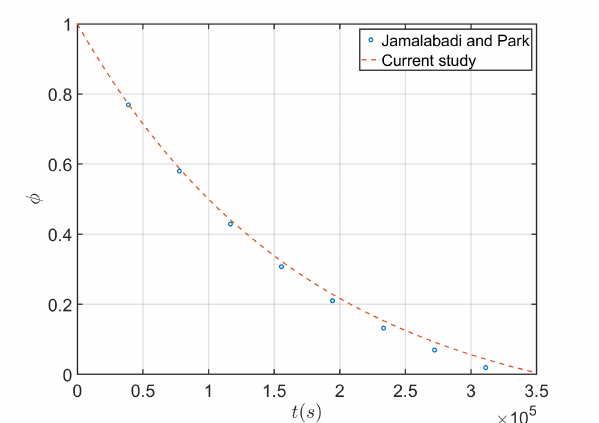
Figure 4. Validation of fluid part by comparing the solid percent of PCM versus time in a melting